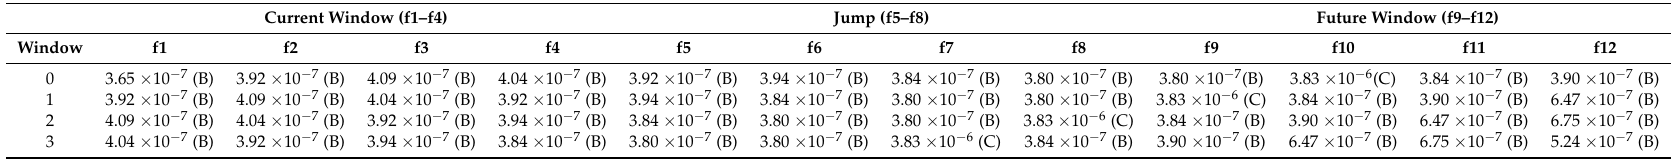
Table 3. Example of the values of the windows built in